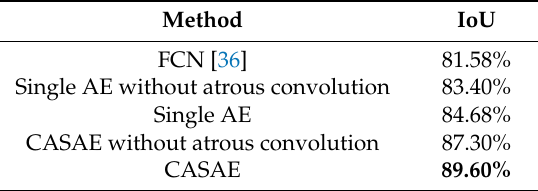
Table 3. The quantitative performance of segmentation results with different methods.